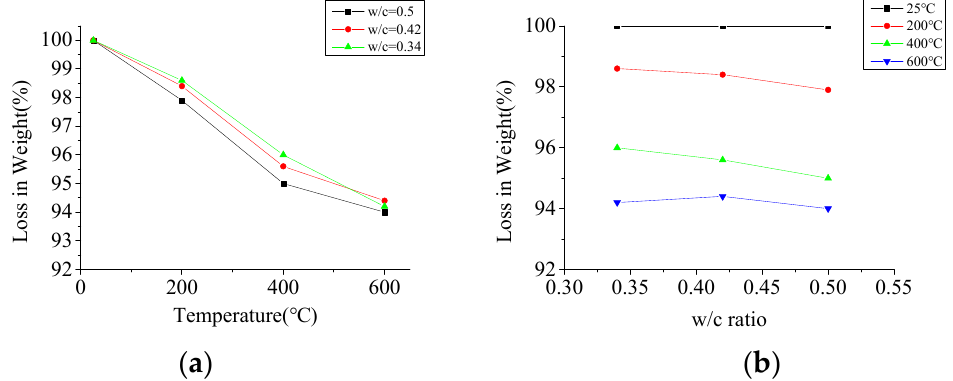
Figure 6. The weight loss of the specimens; (a) the effect of elevated temperatures on the weight loss, (b) the effect of w/c ratio on the weight loss.